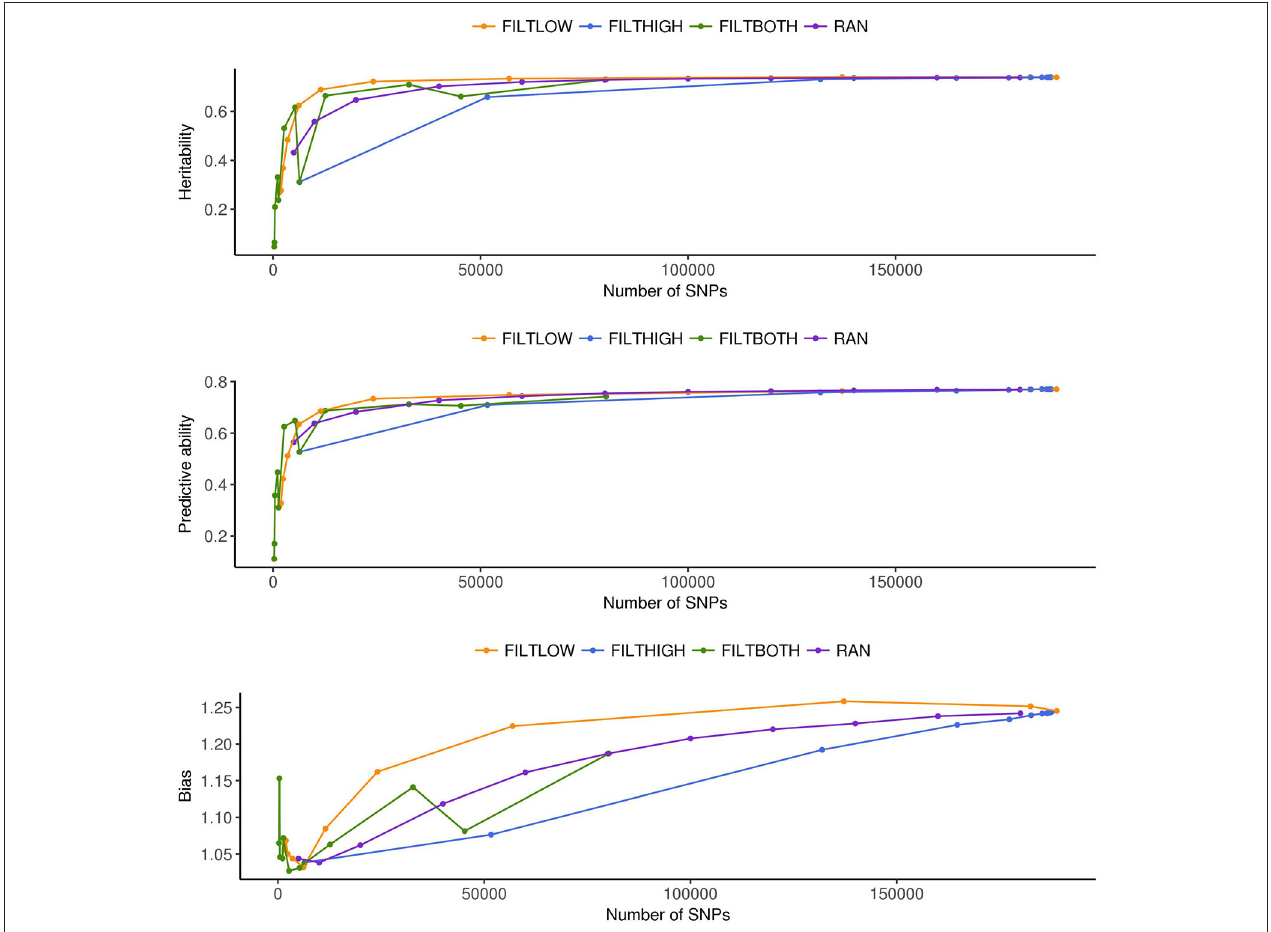
FIGURE 4 | Estimated heritability, predictive ability and bias in different SNP filtering scenarios 1 for heading date. 1 FILTLOW, strategy filtering out SNPs having low average depth; FILTHIGH, strategy filtering out SNPs having high average depth; FILTBOTH, strategy filtering out SNPs having both low average and high average depth; RAN, strategy keeping SNPs randomly with different data